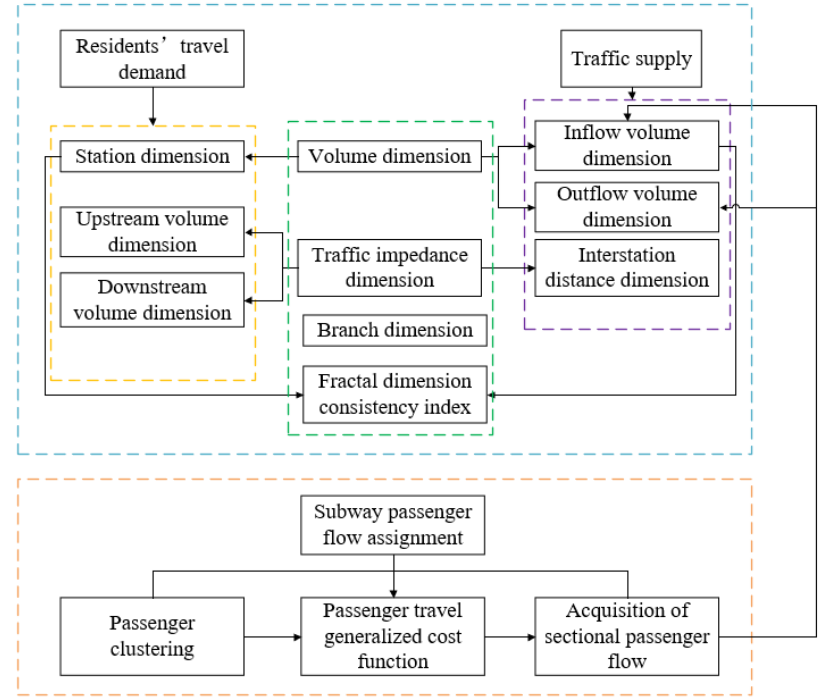
Figure 2. The flow chart of the combination of subway flow assignment and fractal dimensions.